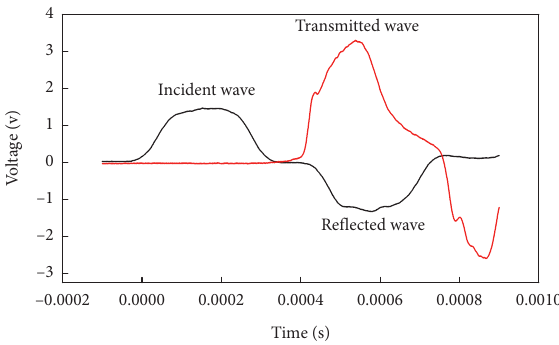
Figure 3: Acquisition waveform of impact compression